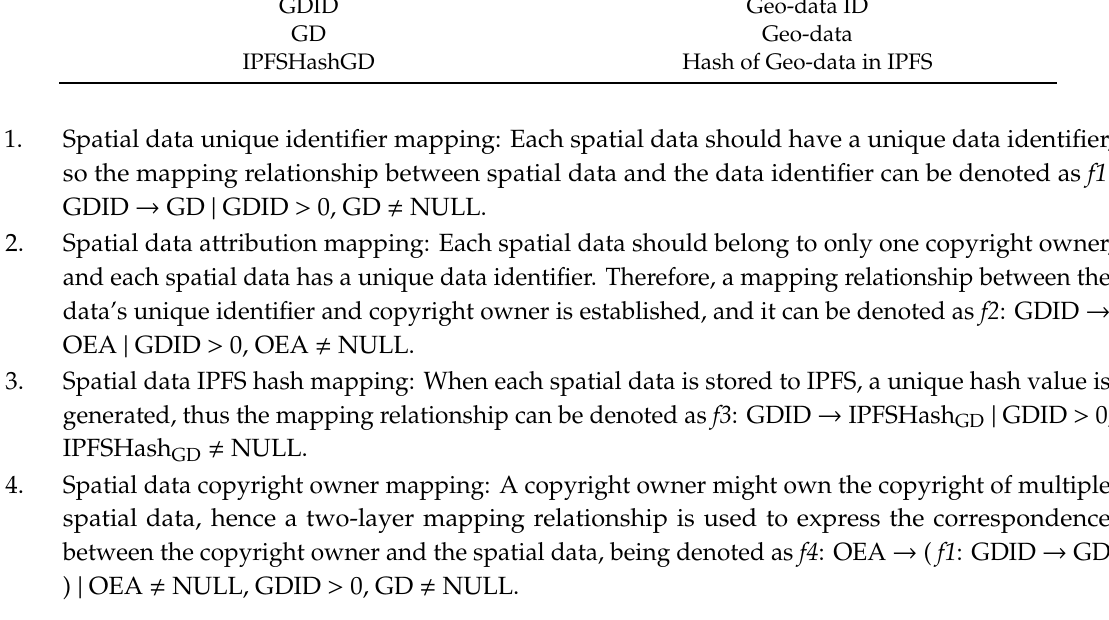
Figure 2. Mapping relationships in GDRM-OM.